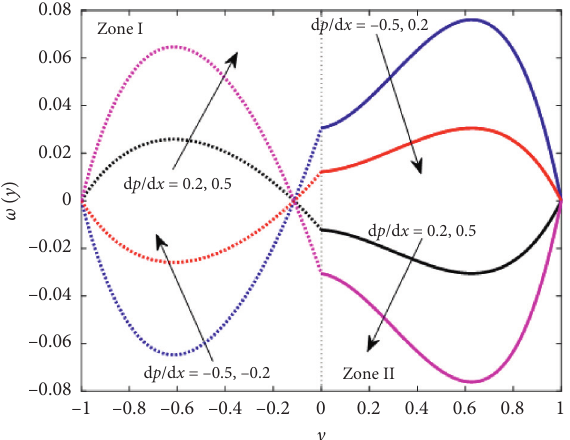
Figure 13: Microrotation profiles for various d p /d x .